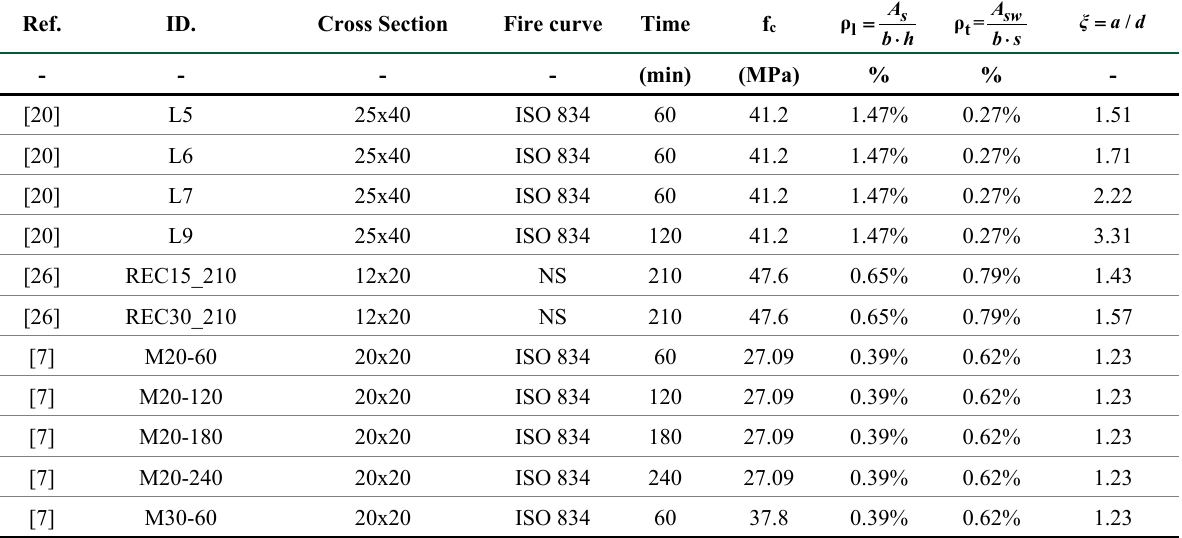
Table 1. Identification and characteristics of beams analyzed by bending Ref. ID. Cross